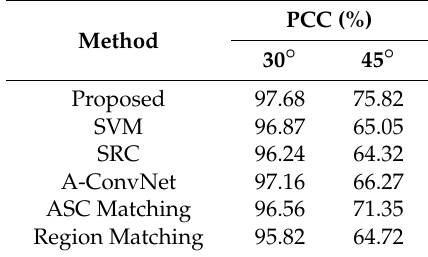
Table 10. PCCs of all the methods at 30° and 45° depression angles.